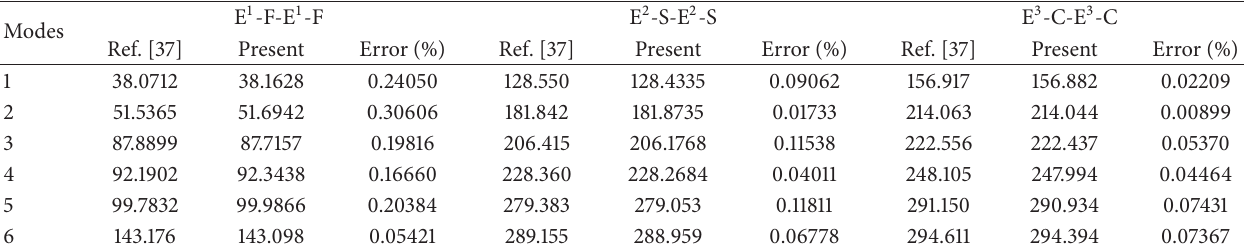
Table5:Firstsixfrequencyparameters Ω = 𝜔𝐿 2 √𝜌ℎ/𝐷 foranopencylindricalshellsubjectedtovariousclassical-elasticcombinedboundary